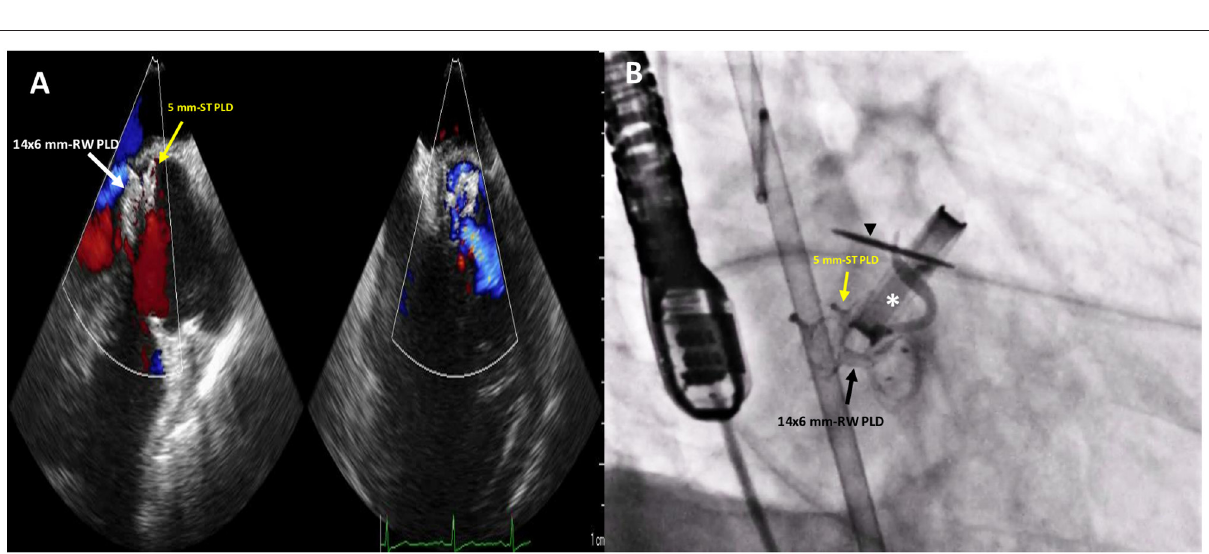
from the right femoral artery, we easily advanced and passed through the huge NCC leakage a hydrophilic Terumo 0.035 inch guide wire, then replaced by a super stiff guidewire 0.035-inch